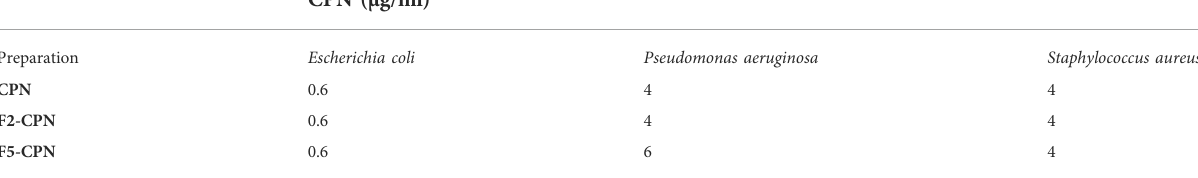
TABLE.2 Concentrations of CPN in F2-CPN, F5-CPN, and CPN solution were used to determine TKA against E. coli , S. aurous , and P. aeruginosa